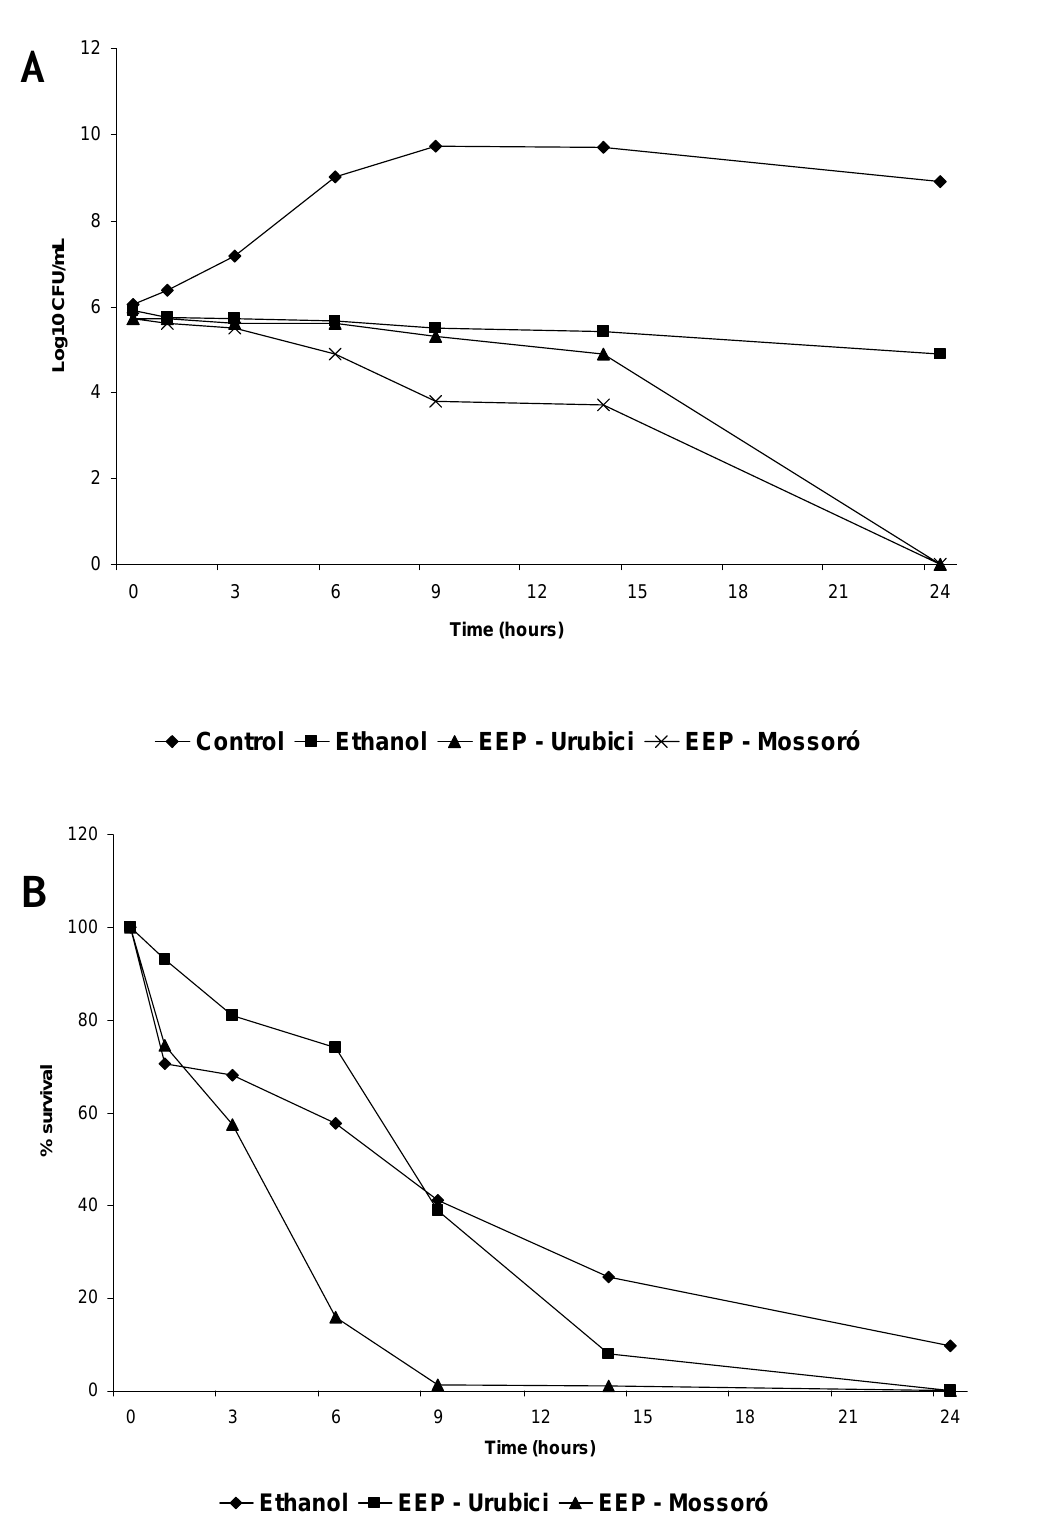
Figure 2. Profile in time of the Population Analysis (A) and Survival Curve (%Cfu/mL) (B) of Salmonella t yphimurium according to the incubation period in EEP (10.0%v/v) and 70% Ethanol (12.6%v/v). X 2 = 20.559; p <